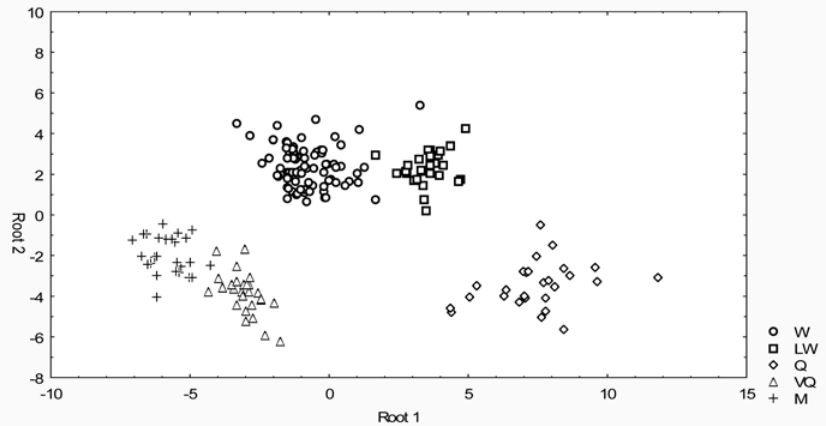
Fig. 1: discriminant analysis of cuticular hydrocarbons present in the castes. W (workers), LW (major workers), Q (queens), VQ (Virgin queens) and M